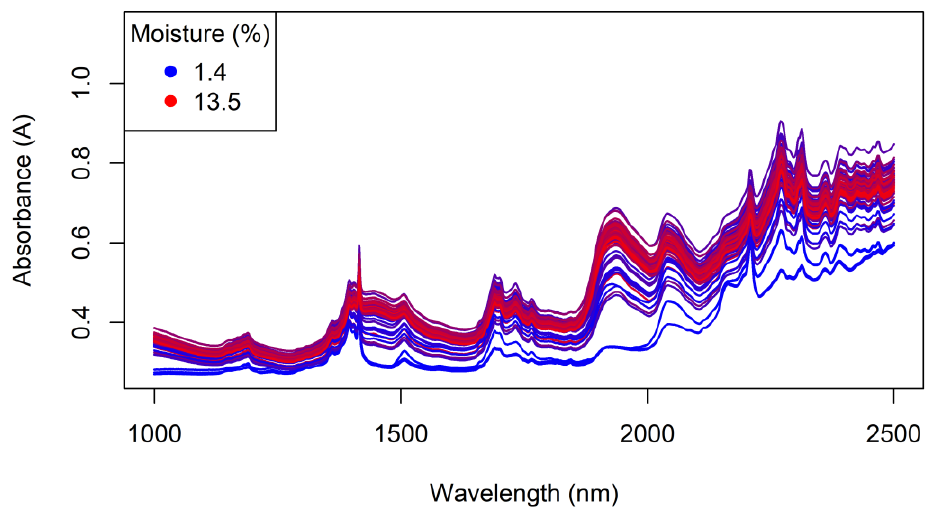
Figure 17. The benchtop NIR spectra of the powdered Regain samples, coloured by moisture content.